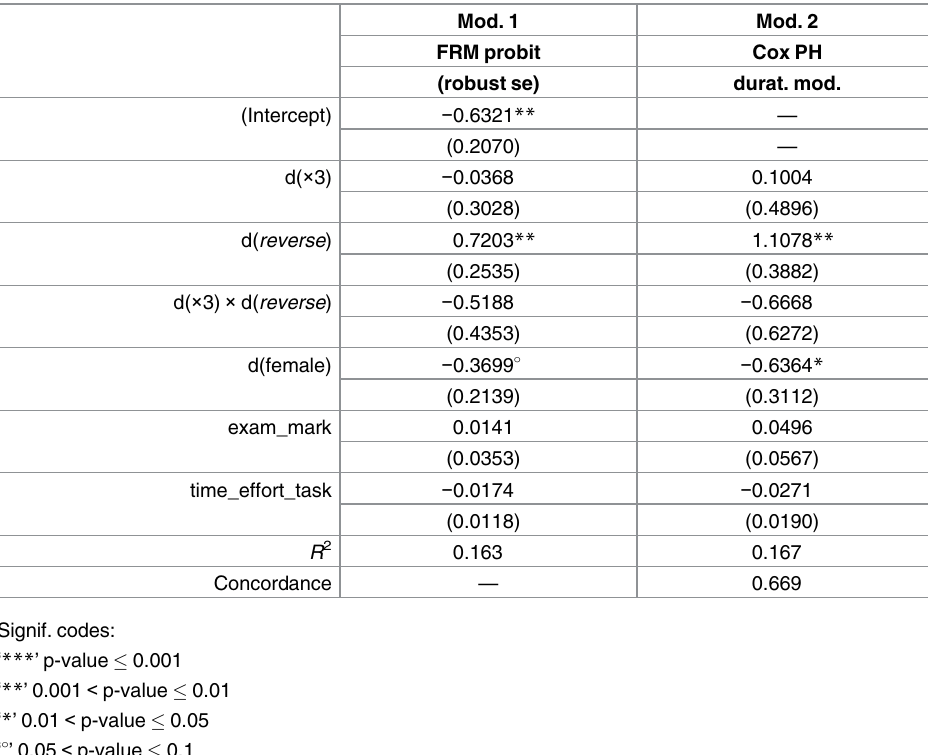
Table 2. Regressions’ estimates with s.e. in